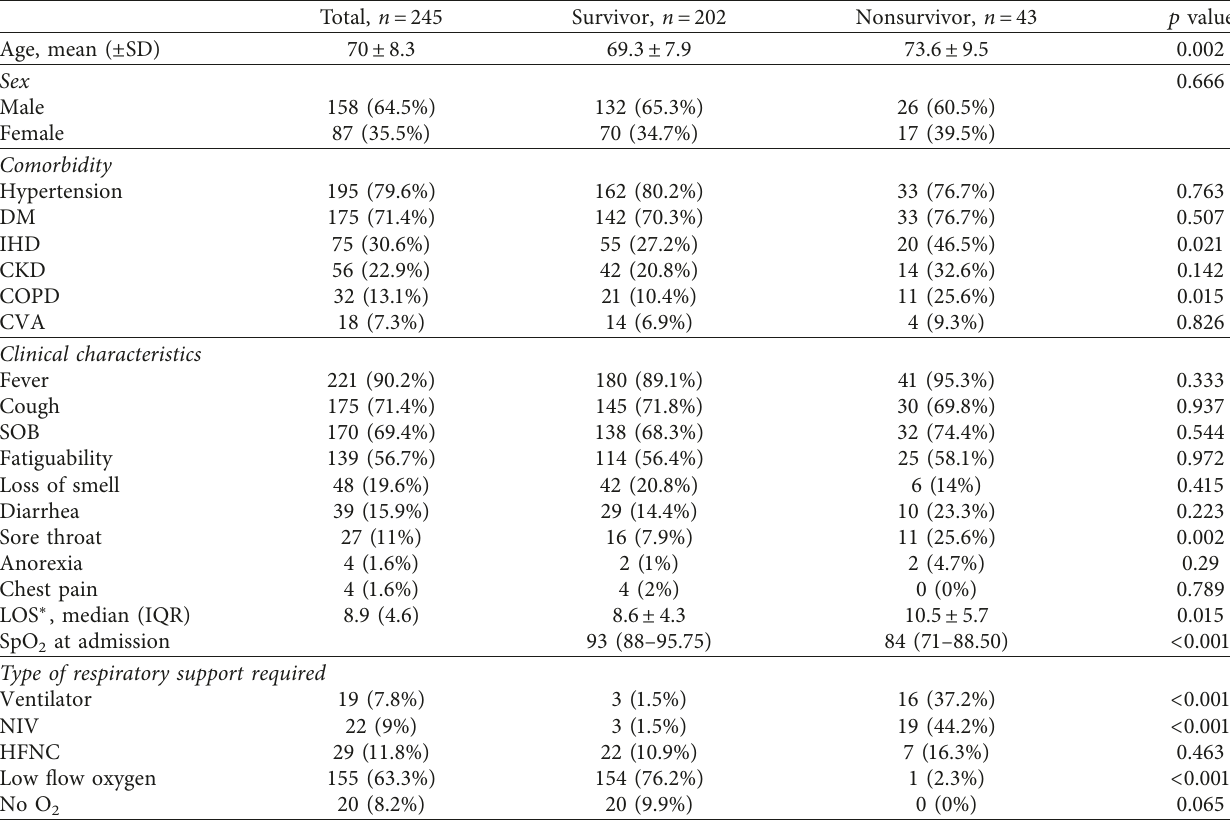
Table 1: Demographic and clinical characteristics of patients with COVID-19.